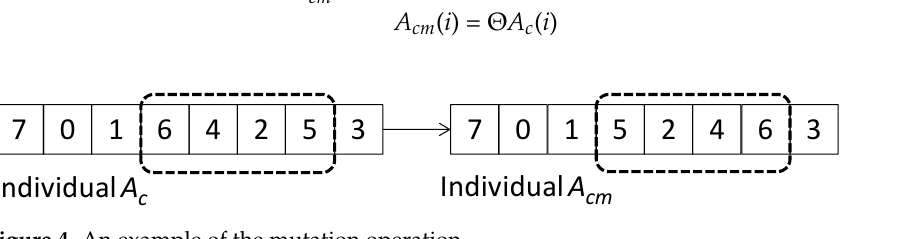
Figure 3. An example of the crossover operation.